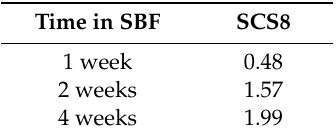
Table 4. Ca / P molar ratio at di ff erent immersion times soaked in Table 4. Ca/P molar ratio at different immersion times soaked in SBF.